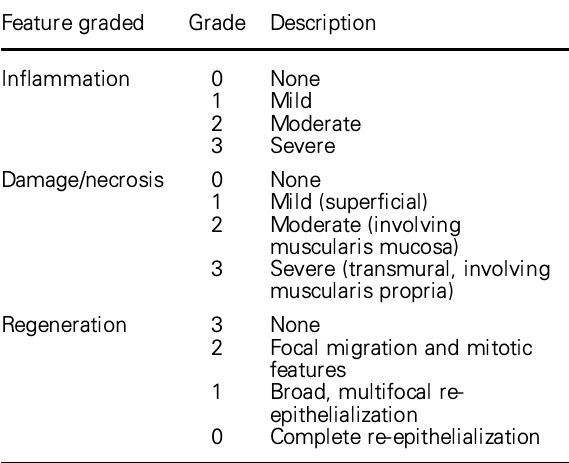
Table 1. Histologic grading of colitis Feature